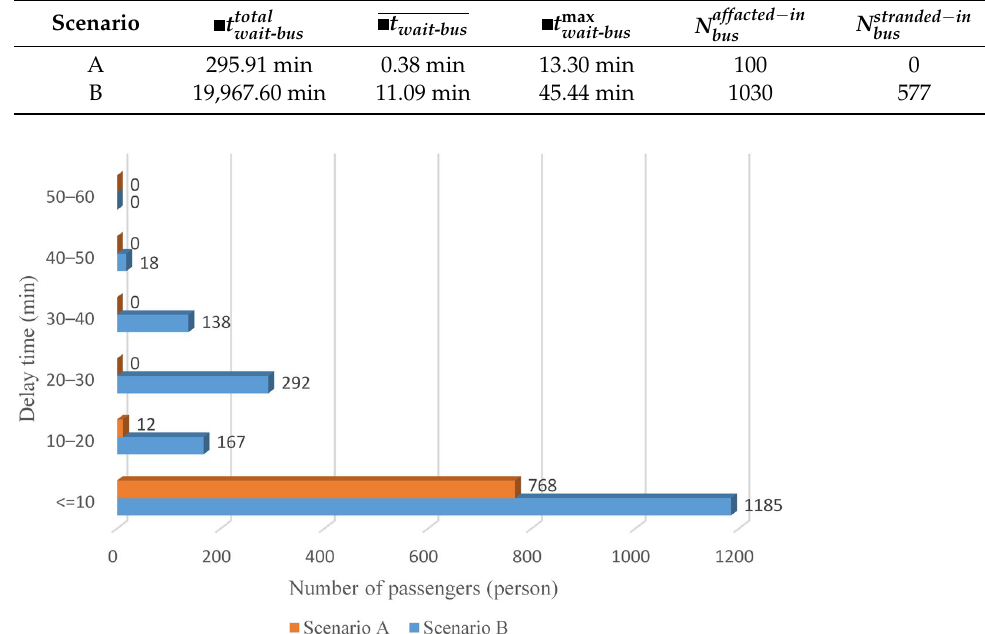
Table 10. Estimation results of delay time and affected bus passenger flow.